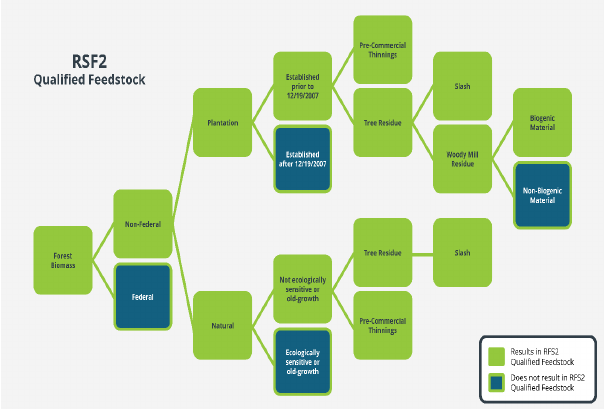
Figure 2 . Renewable Fuel Standard of eligible and non-eligible feedstock for biofuels (Reprinted with permission from Ref. [29]). 6. Increasing the Use of Woody Biomass in the U.S. The promotion and use of forest biomass for bioenergy and bioproducts is complex. What follows is a list of suggestions to increase the use of woody biomass. 1. Multiple definitions are contained within different programs supporting the use of forest biomass for bioenergy and other bioproducts. The restriction for using biomass from public lands discourages private industry investments and it decreases the